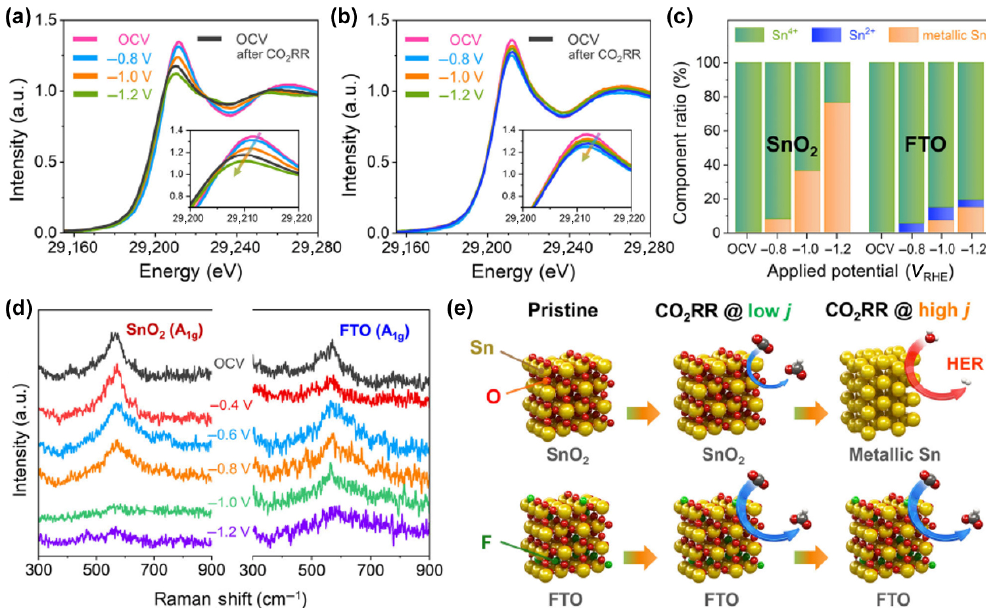
Figure 3 In-situ / operando spectroscopy analyses for raveling origin of durability. In-situ / operando Sn k-edge XANES spectra for (a) SnO 2 /C and (b) FTO/C catalysts during CO 2 RR in the flow-type electrolyzer and (c) its oxidation state distribution deconvoluted by linear combination fitting (orange: Sn, blue: Sn 2+ , and green: Sn 4+ ). (d) In-situ / operando SER spectra obtained at constant potentials for SnO 2 and FTO catalysts without carbon supporter. Analyzed SER spectra present in the wavenumber region of 300‒900 cm –1 . (e) Schematic illustration of reaction affinity for SnO 2 and FTO under low/high cathodic overpotential. Reproduced with permission from Ref. [28], © Ko, Y. J. et al.